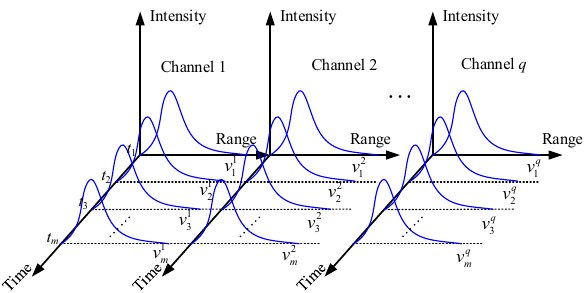
Figure 1. Four-dimensional structure of the multi-channel lidar data.